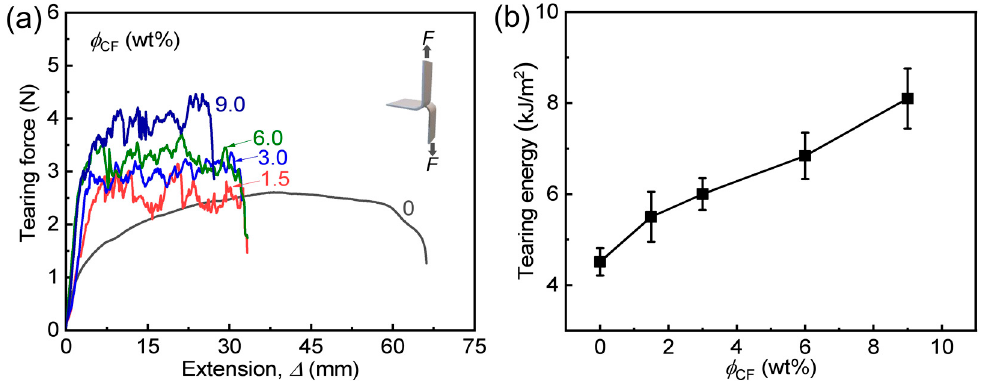
Figure 4. Tearing behavior of PA/CF composite hydrogels with different ϕ CF . ( a ) Tearing force ( F )- extension ( Δ ) curves of the samples. ( b ) Tearing energy versus ϕ CF .